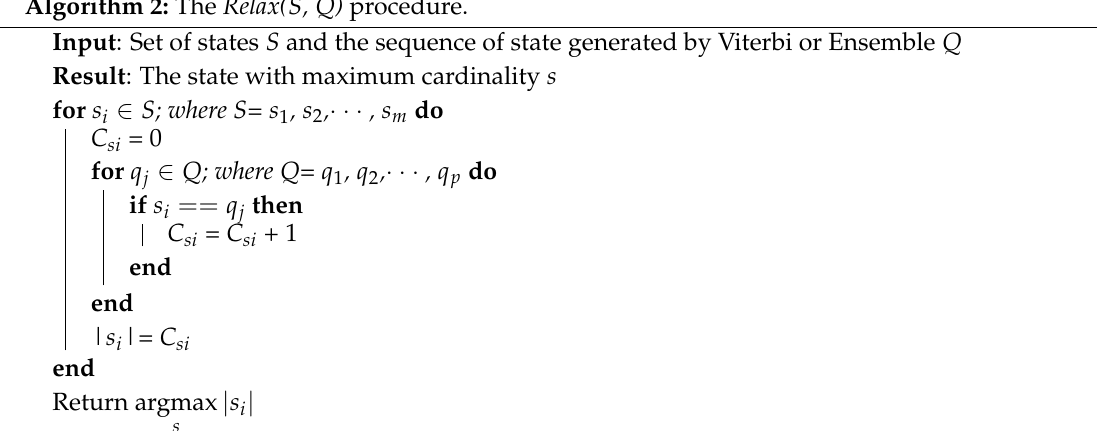
Algorithm 2: The Relax(S, Q)